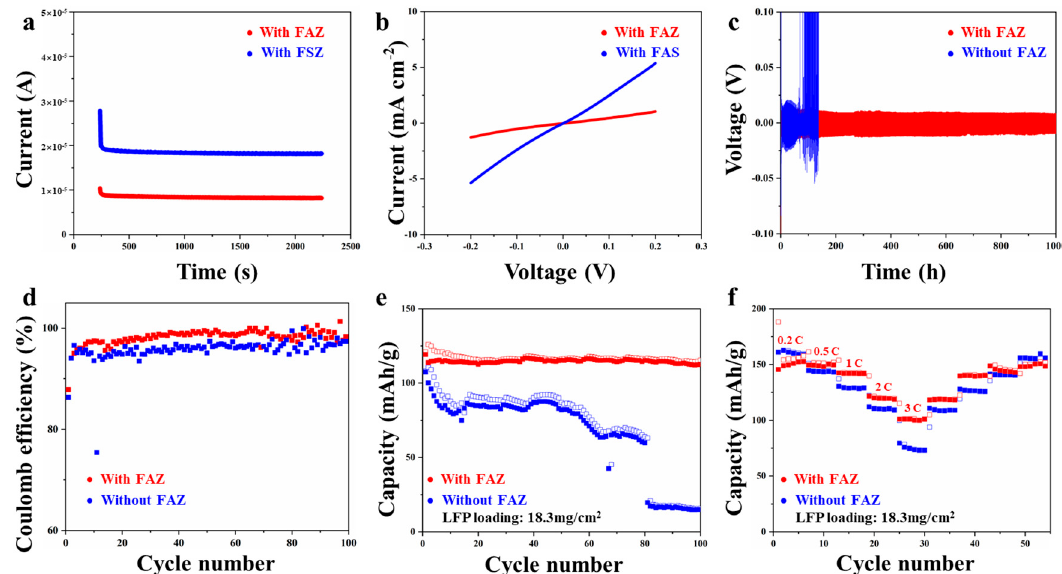
Figure 5. Electrochemical performances of various nanospheres. ( a ) Lithium ion transference numbers of the Li||Li symmetric battery with FAZ nanospheres (0.81) and FSZ nanospheres (0.65). ( b ) Exchange current densities of the Li||Li symmetric batteries with FAZ and FAS nanospheres. ( c ) Cycling performances of the Li||Li symmetric batteries at 1 mA/cm 2 − 1 mAh/cm 2 . ( d ) CE of Li||Cu battery at 1 mA/cm 2 − 1 mAh/cm 2 . ( e ) Cycle performances of LFP full battery at 1 C. ( f ) Rate performance of LFP full battery from 0.2 C to 3 C.